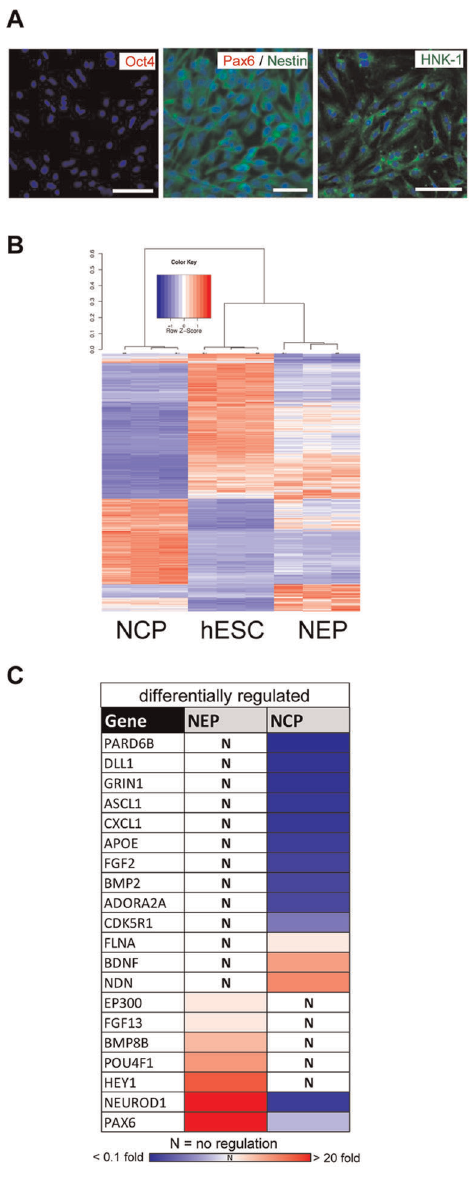
Figure 4. Alternative early neural differentiation to neural crest progenitors. (A) hESC were differentiated towards NCP and stained with antibodies specific for OCT4 (no stain observed), PAX6 (no stain observed), NESTIN and HNK-1 . Cell nuclei were labeled with the DNA dye Hoechst H-33342 (blue). Scale bars: 100 m m. (B) Pairwise comparisons of hESC, NEP or NCP yielded 4277 differentially expressed transcripts. The heat map displays the genes after clustering according to the Pearson’s correlation of their expression values across samples. The colors represent Z-scores of the row-wise normalized expression values for each gene. The dendrogram indicates the pattern similarities indicated by Spearman correlation distances (1- Spearman correlation coefficient) and shows a large separation of NCP from NEP and hESC. (C) The expression of early neuronal marker genes was measured in three preparations each of hESC, NEP and NCP by qPCR. The transcript levels of NEP and NCP were calculated relative to hESC. The relative gene expression levels were color coded (significant down-regulation vs. hESC in blue; significant up-regulation in red; non-significant changes marked by ‘‘N’’. The genes showing different behavior in NEP vs NCP are displayed. All measures of variance and p-values are indicated in the supplemental